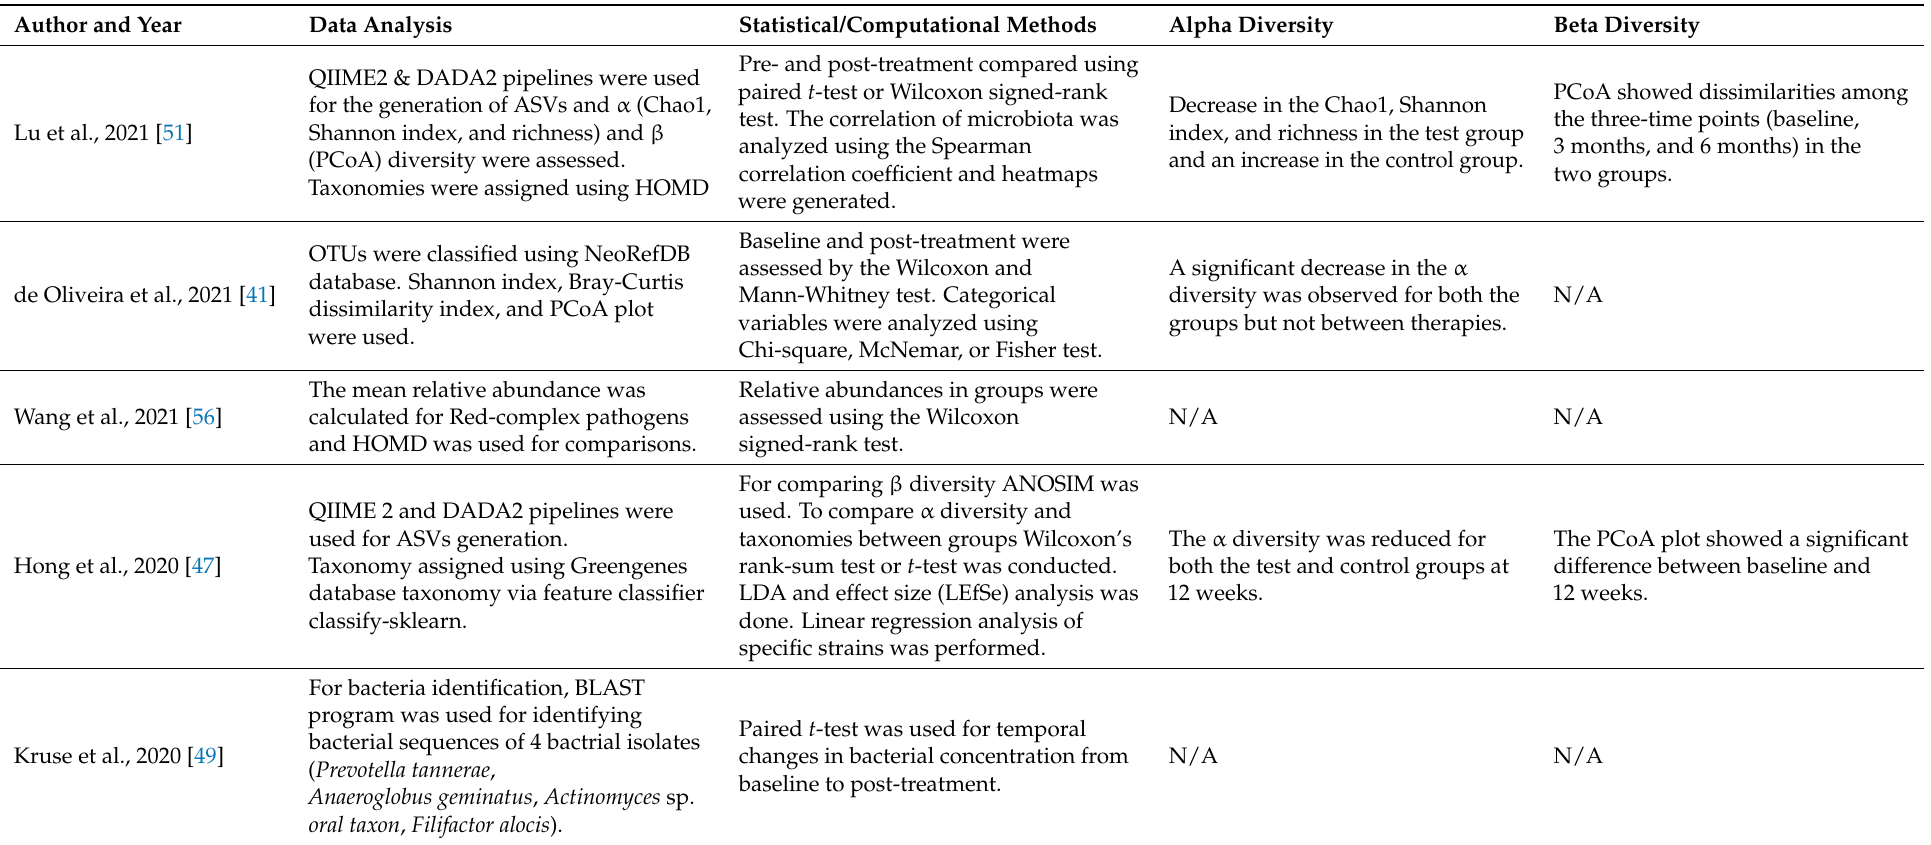
Table 2. Description of microbial data analysis from the included